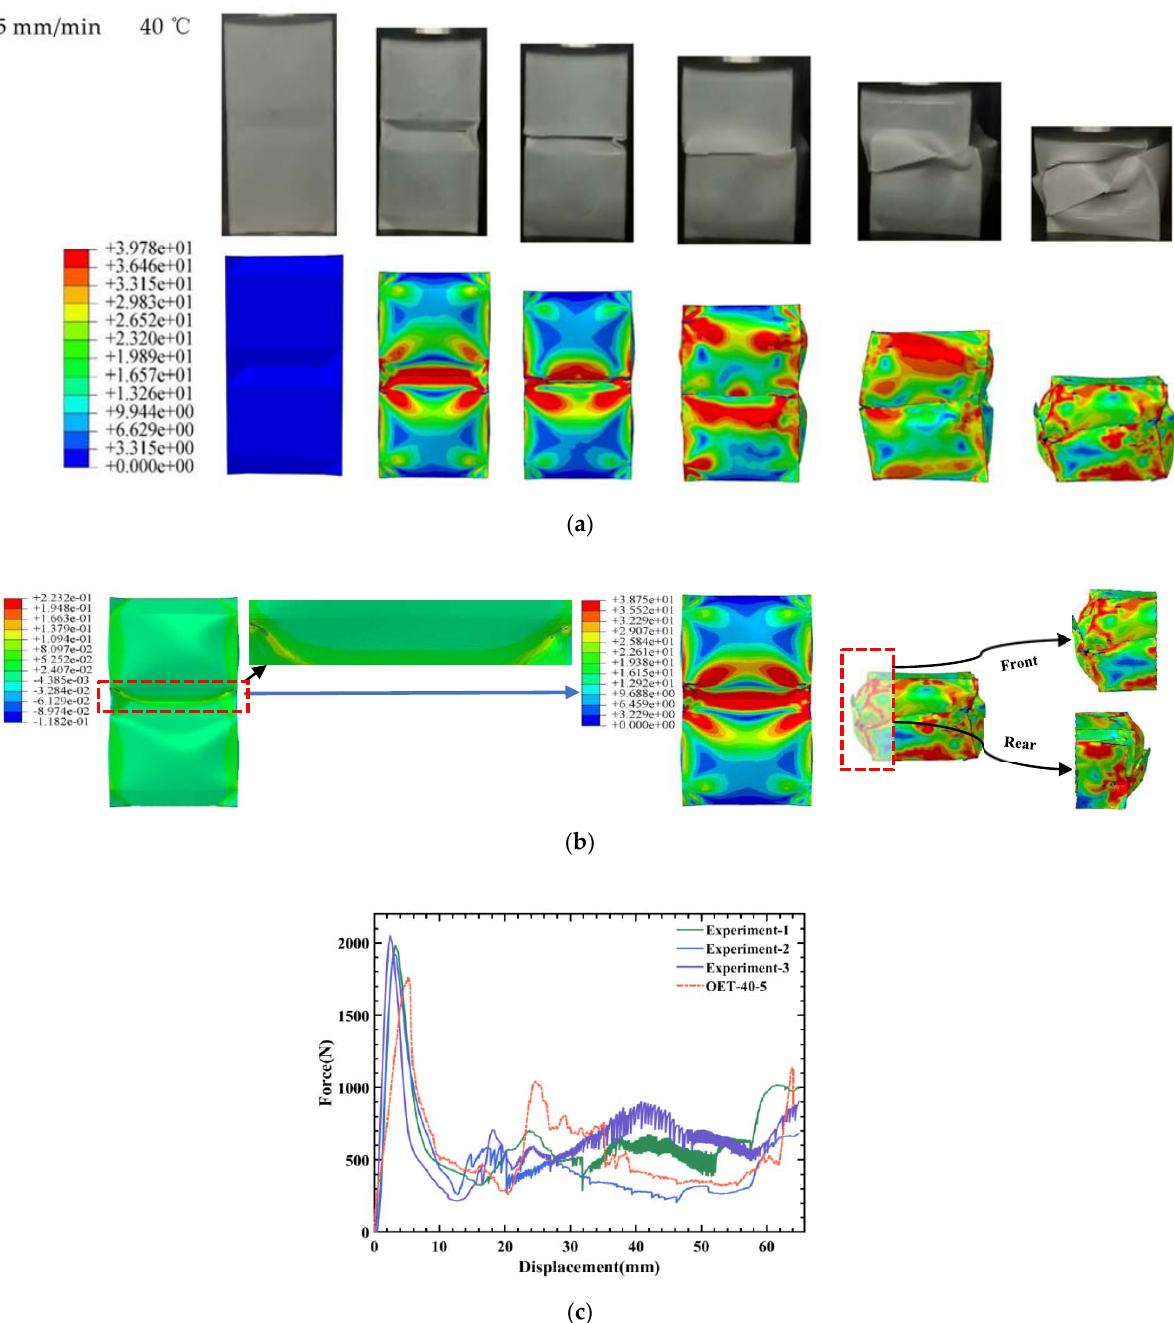
Figure 8. The compression rate at 5 mm/min: ( a ) Comparison of deformation modes between OET axial compression experiment and numerical simulation at 40 °C; ( b ) strain and stress cloud maps of OET at 40 °C; ( c ) comparison of the experimental and simulated force–displacement curves of OET at 40 °C.